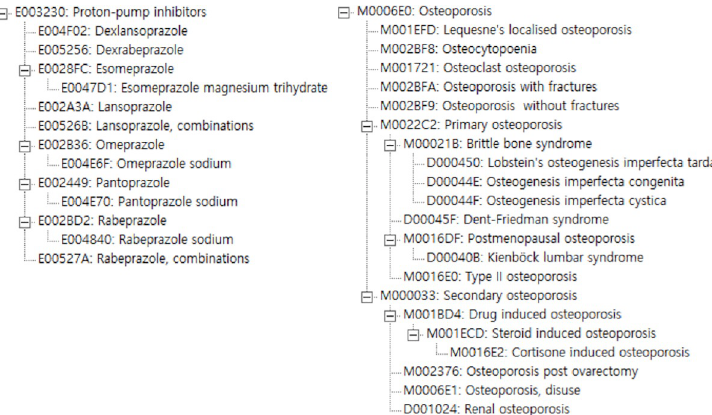
Fig 2. Hierarchical representation of osteoporosis and PPI in the